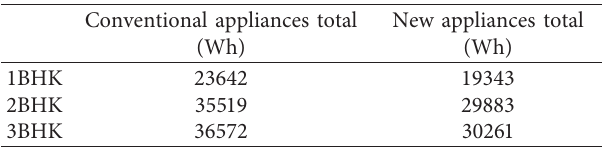
Table 9: Load comparison—conventional vs improvised appliances.